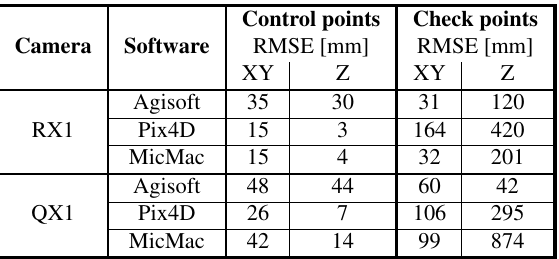
Table 4: Geo-referencing statistics comparison on control and check points, for each camera (Sony QX1 and RX1), and each software.